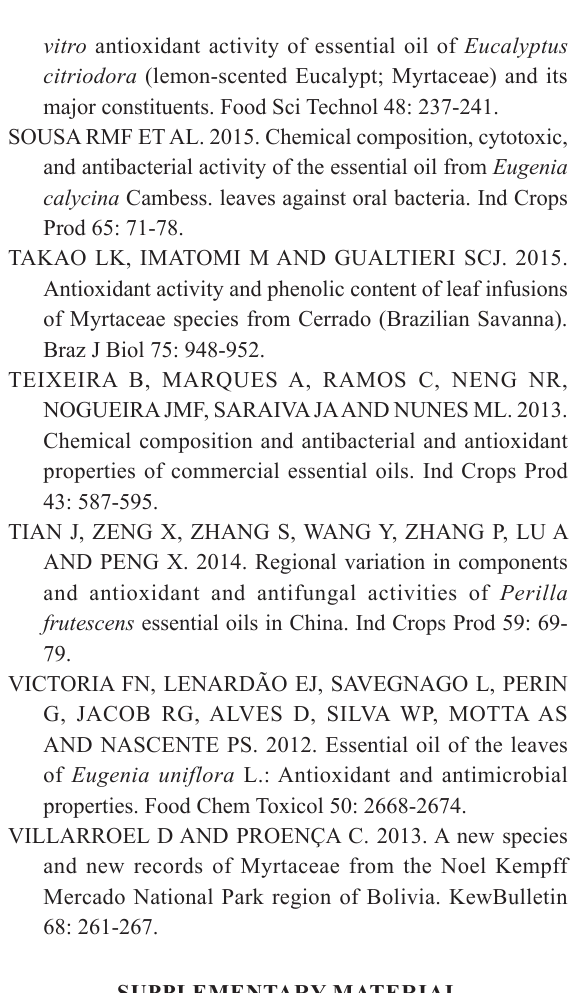
Table SI - Chemical composition of essential oils from leaves and flowers of E. klotzschiana